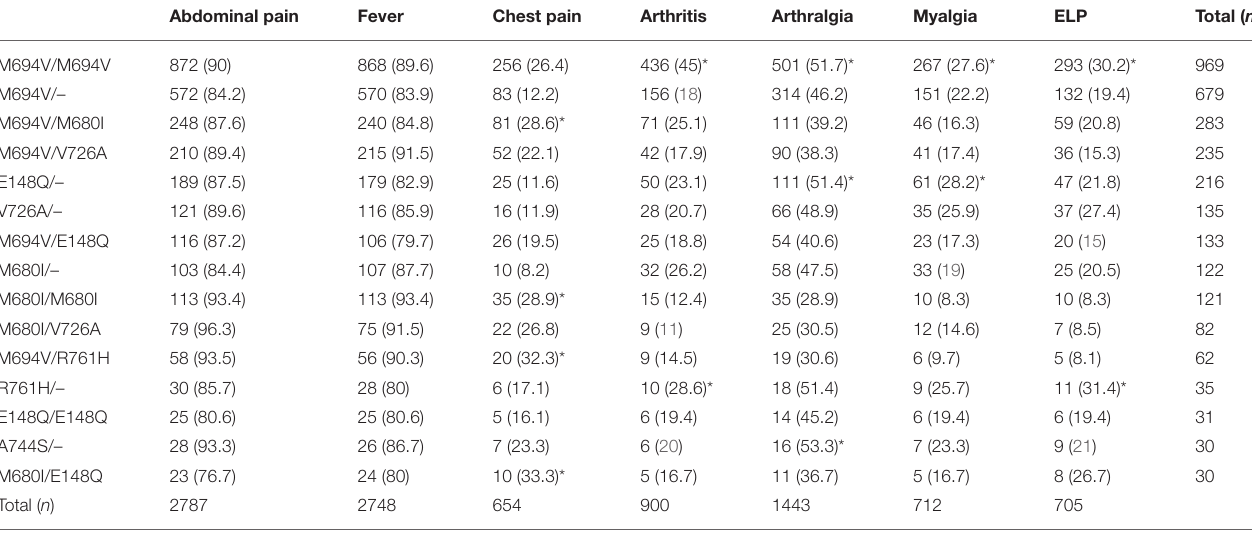
TABLE 3 | Comparison of the most common mutations and clinical findings in familial Mediterranean fever. Abdominal pain Fever Chest pain Arthritis Arthralgia Myalgia